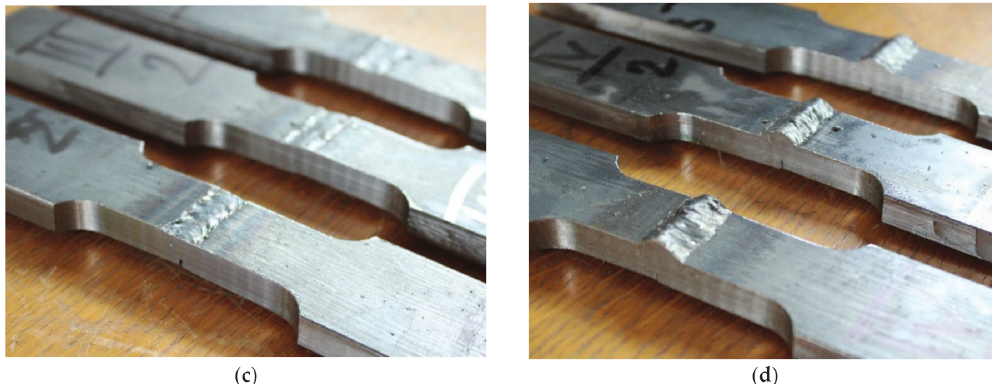
Figure 10. Tensile test specimens with different defect combinations: ( a ) group I—misalignment, undercut, slight excess root penetration; ( b ) group II—misalignment, undercut, incomplete root penetration; ( c ) group III—weld face sagging, incomplete root penetration; ( d ) group IV—excess weld metal, undercut, incomplete root penetration.